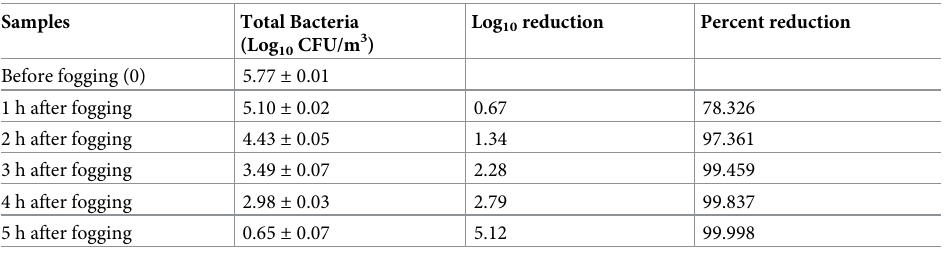
Table 4. Total bacteria and Log 10 reduction on air samples collected from an empty weaning room during Ecas4 anolyte fogging. Data reported as mean ± SEM, n = 4.